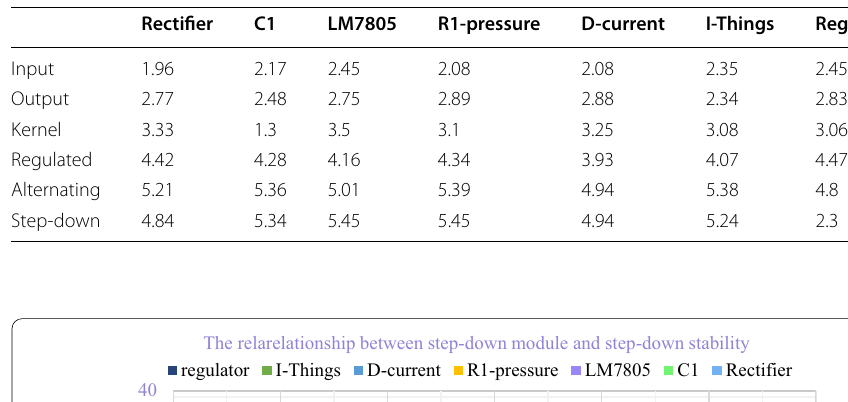
Table 2 Make full use of the acquired data and information results